Question: Write a single sentence explaining what this figure depicts.
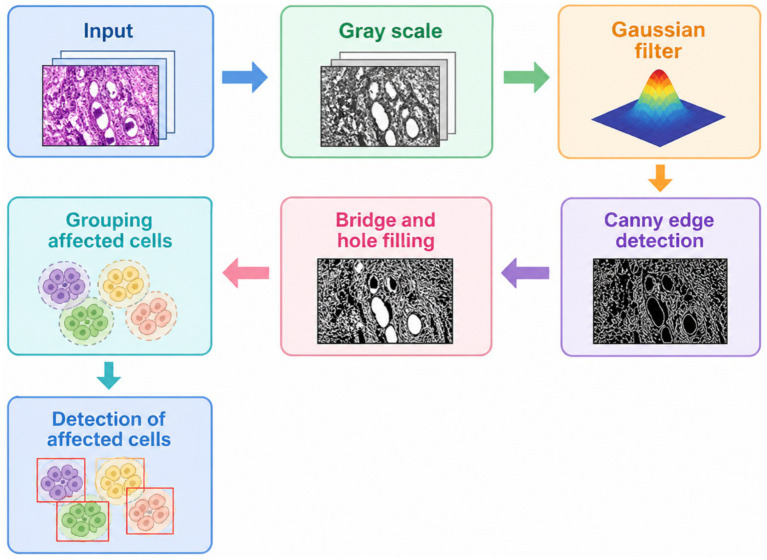
Answer: Steps involved in image preprocessing.